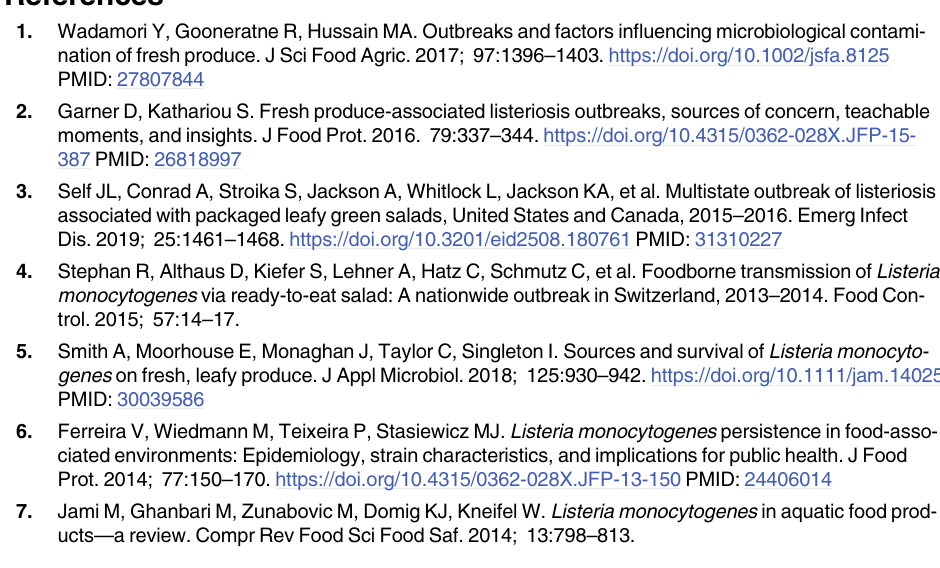
S1 Table. LC-MS/MS data of compounds contained in the anti-listerial fraction isolated from Eruca sativa —further